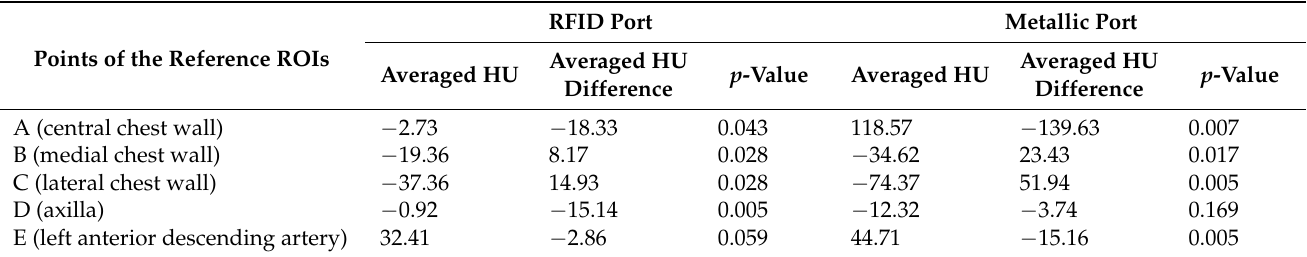
Table 2. Comparison of Hounsfield